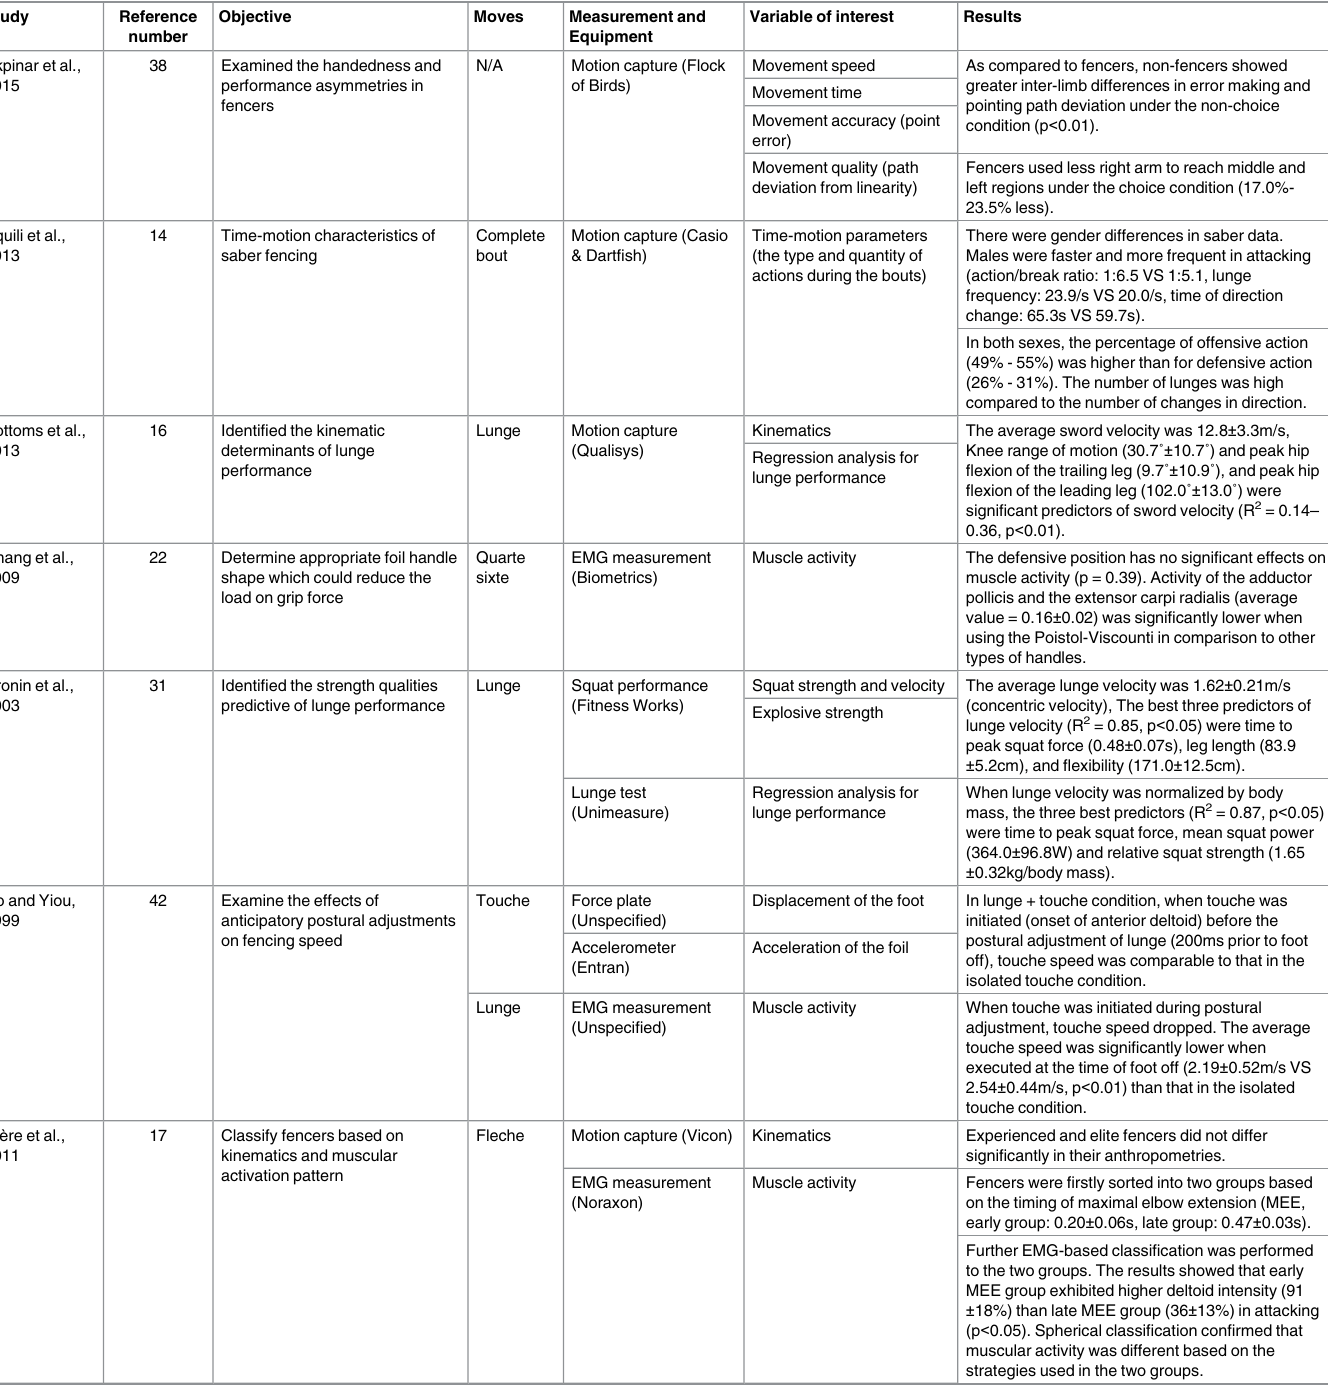
Table 2. Methodological characteristics of studies included in our